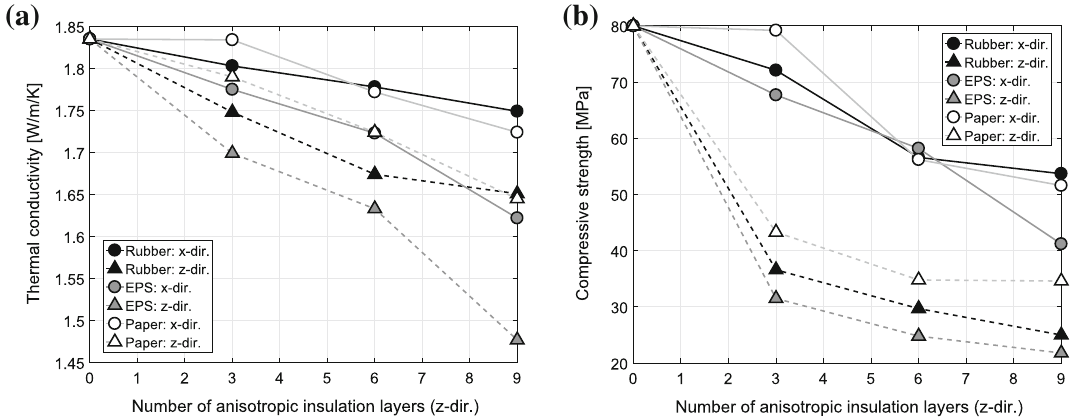
Fig. 9 Comparison of experimental material properties of the insulating specimens with different insulations for the x and z directions: a Thermal conductivity, b Compressive strength.